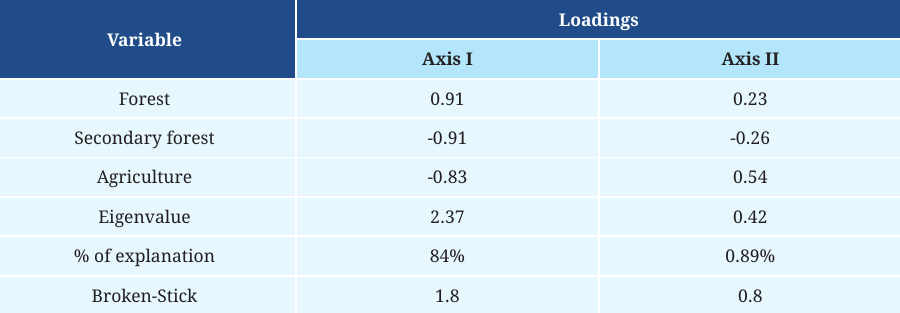
TABLE 1 | Land-use classes identified in riparian buffers in the catchment of nine streams in the Tanguro Farm, Municipality of Querência, state of Mato Grosso, and their correlations to Axis I of the